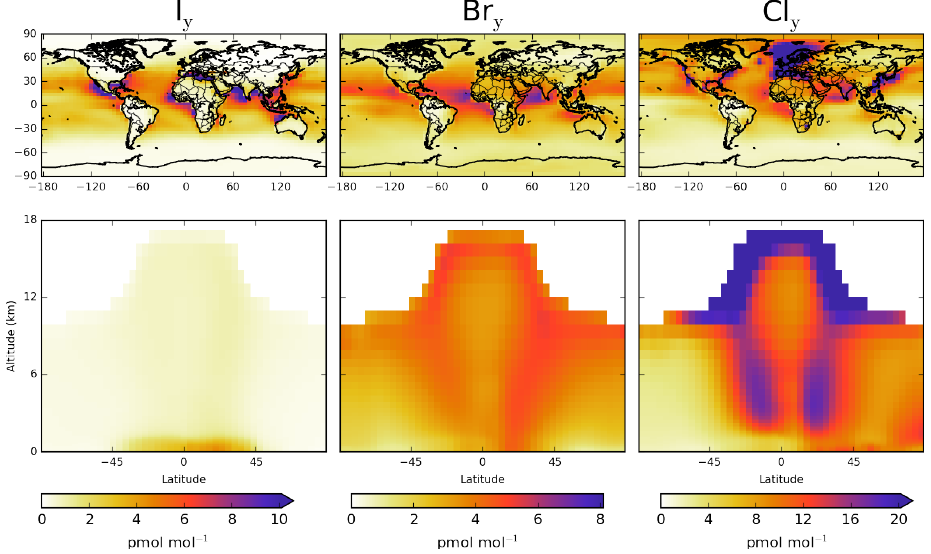
Figure 3. Tropospheric distribution of Cl y , Br y , and I y (defined in Appendix C) concentrations. Upper plots show surface and lower plots show zonal values. Only boxes that are entirely tropospheric are included in this plot. The Cl y colour bar is capped at 20pmolmol − 1 , with a maximum plotted value of 116pmolmol − 1 at the surface over the North Sea. The I y colour bar is capped at 10pmolmol − 1 , with a maximum plotted value of 16.4pmolmol − 1 at the surface over the Red Sea.